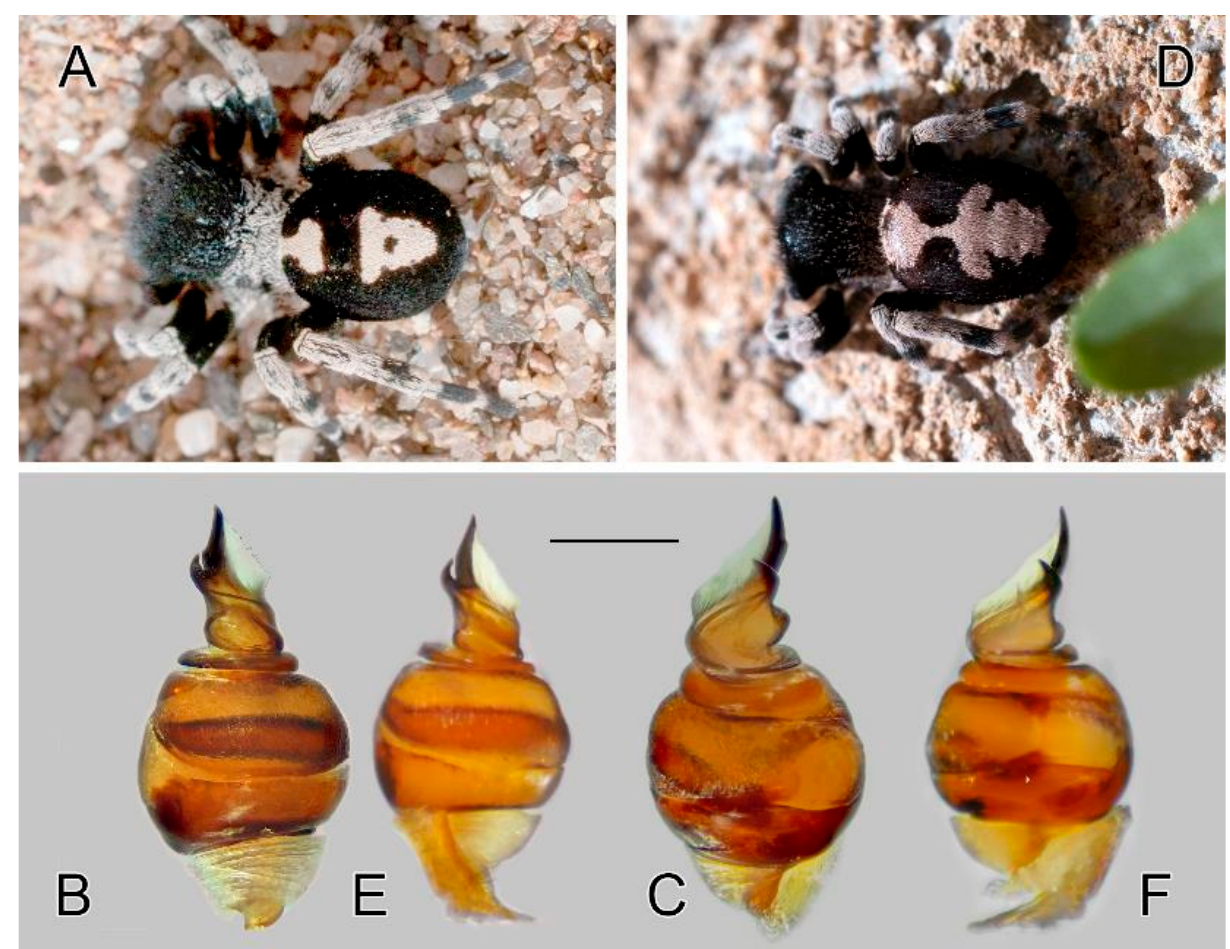
Figure 15. Intraspecific variation in Loureedia colleni . ( A – C ) male color form 1, ( D – F ) color form 2. ( A ) male habitus dorsal view; ( B ) bulb retrolateral view; ( C ) prolateral view; ( D ) male habitus, dorsal view; ( E ) bulb retrolateral view; ( F ) prolateral view. Scale bar: 0.25 mm.